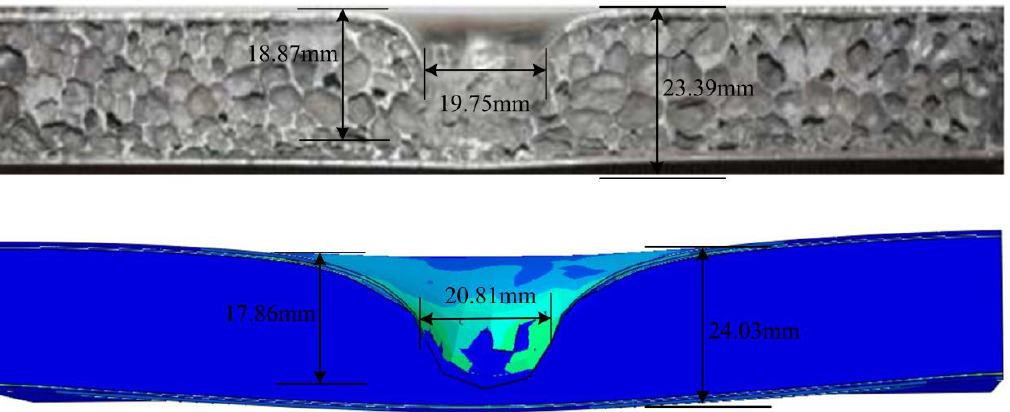
Figure 6. Failure state of the CSP subjected to impact from the experiment and numerical model- ling.